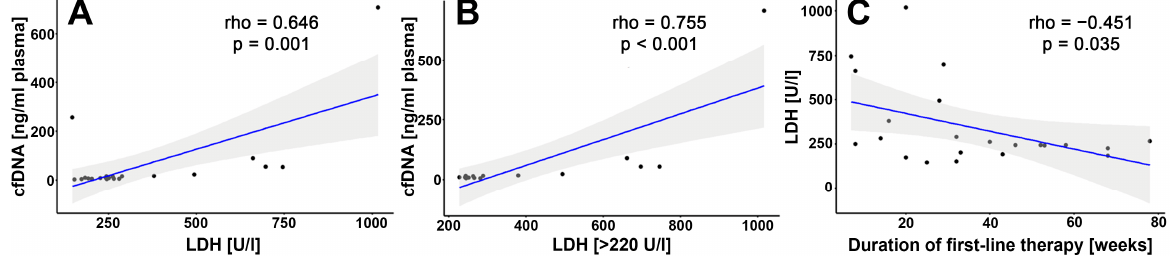
Figure 1. Spearman’s rank-order correlation analysis of: ( A ) LDH level and cfDNA concentration ( n = 22); ( B ) elevated LDH level (>220 U/L) and cfDNA concentration ( n = 16); ( C ) LDH level and duration of first-line therapy ( n = 22). p -values < 0.05 were considered statistically significant.